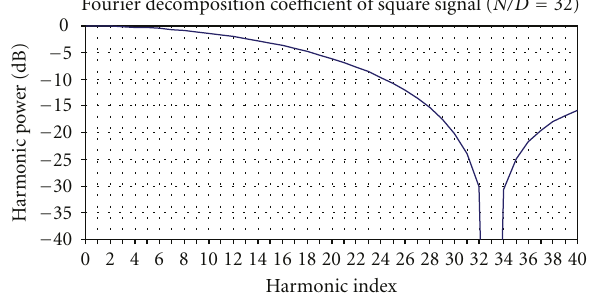
Figure 7: Fourier coe ffi cient values for N/D = 32.